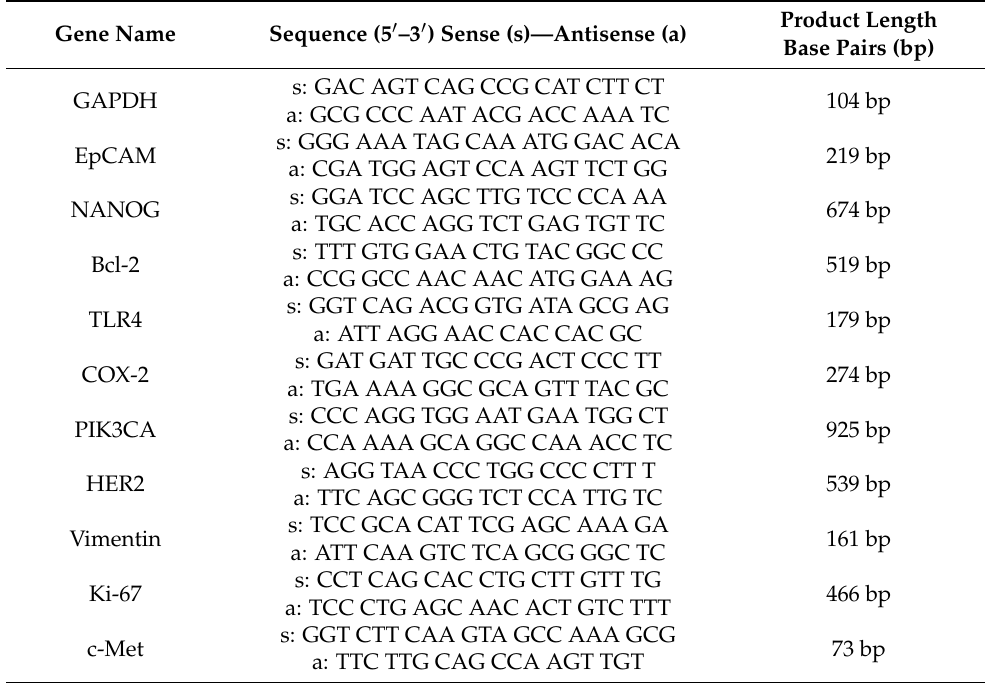
Table 1. Gene expression analysis and respective primer